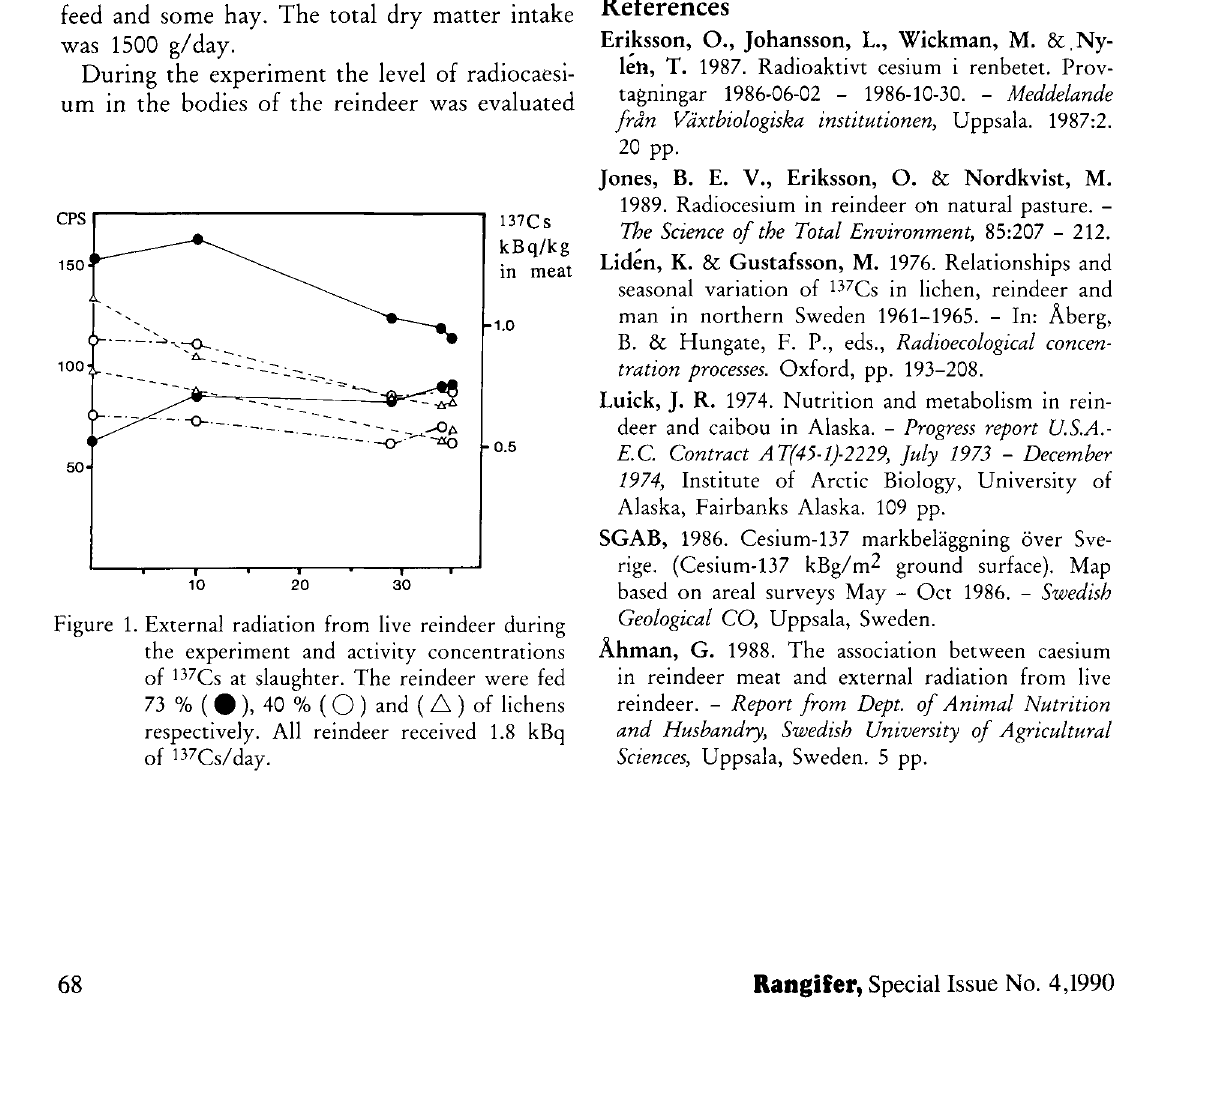
Figure 1. External radiation from live reindeer during the experiment and activity concentrations of 137 Cs at slaughter. The reindeer were fed 73 % ( # ), 40 % ( O ) and ( A ) of lichens respectively. All reindeer received 1.8 kBq of i37 Cs